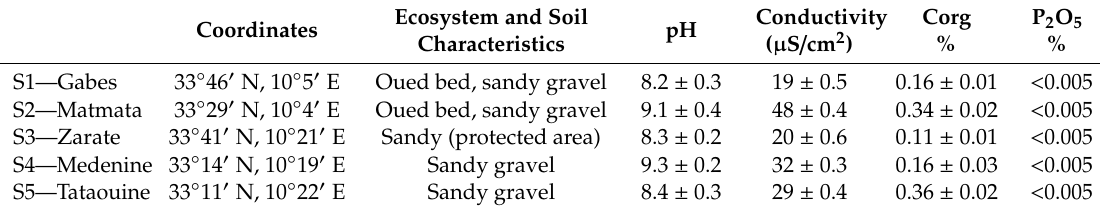
Table 1. Origins of Calicotome villosa nodules isolates, pH and conductivity of soils and ecological characteristics, C and P content of their sampling sites.